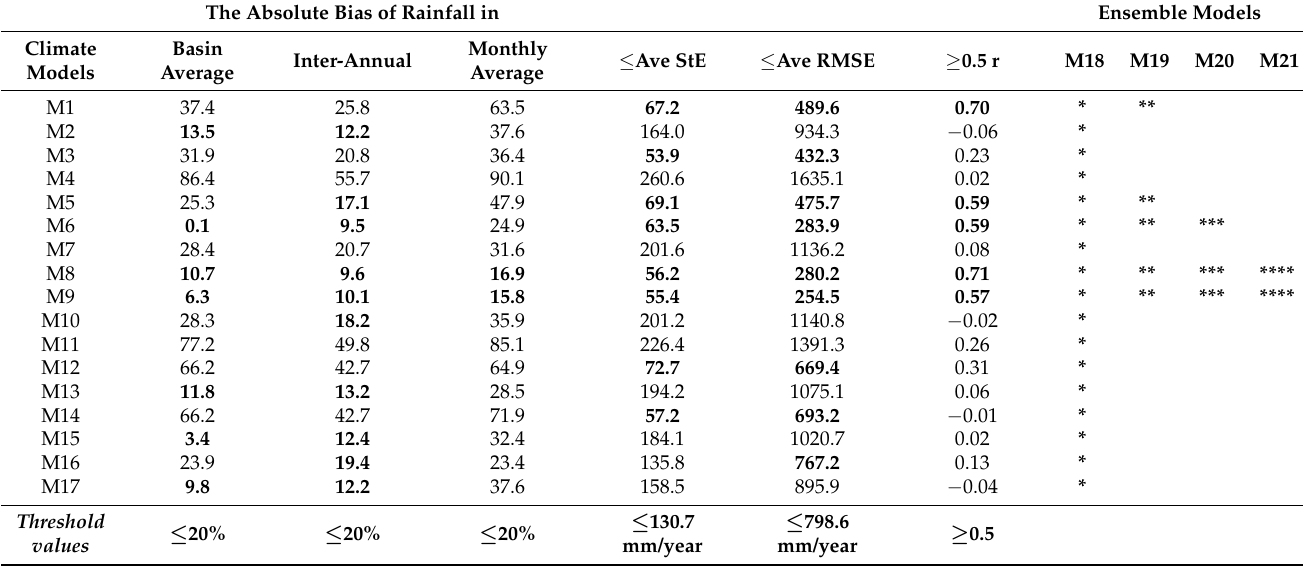
Table 3. Selection of candidate models to form an ensemble under a different range of model performance over the study